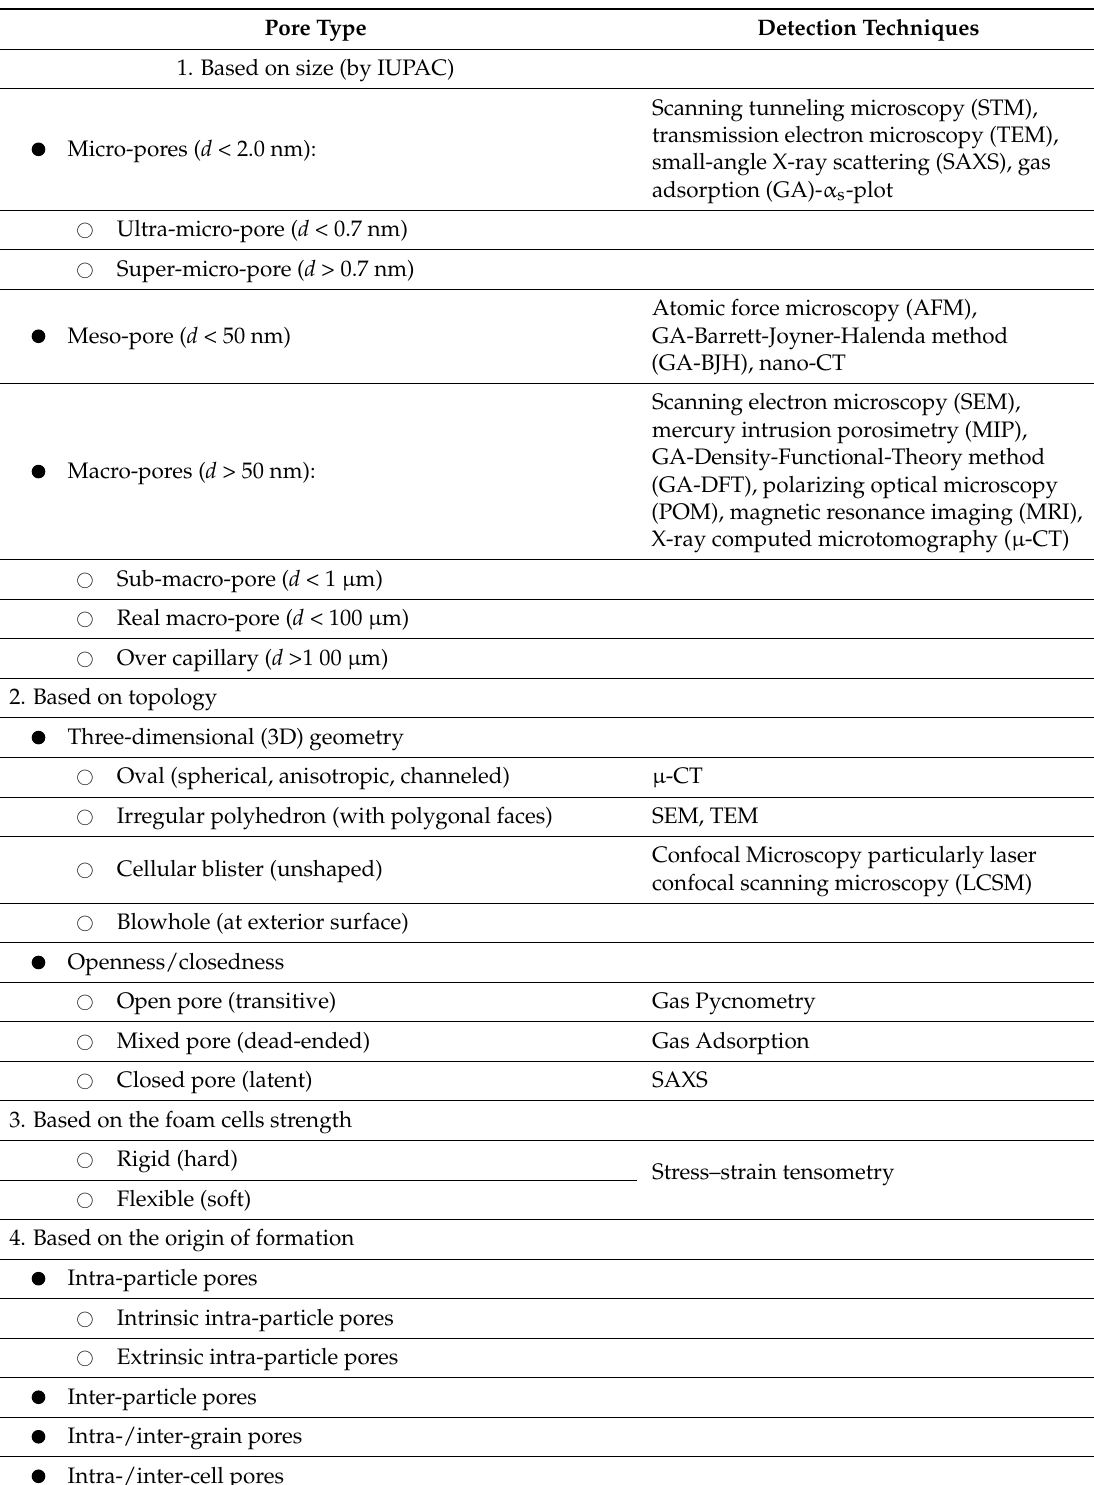
Table 1. Classification of pores or cells in solids and examples of detection techniques that can resolve given pore size range or topological